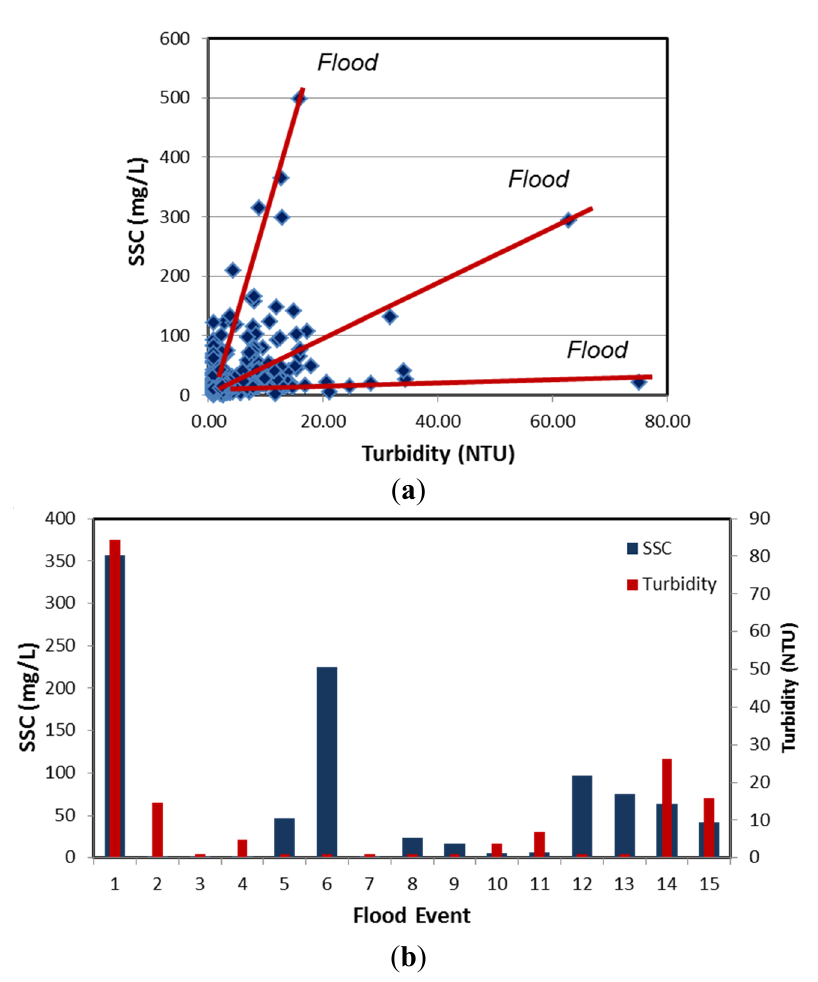
Figure 11. ( a ) Relationships between SSC and turbidity at the Old Bald #1 site ( n = 511). Values are plotted in arithmetic scale to more effectively show that different relationships occur between events; ( b ) Peak SSC and turbidity values measured during 15 separate floods at the Allen Creek site between March 2008 and July 2010. Note that some precipitation events initiate a response in SSC, some a response in turbidity, and others a response in